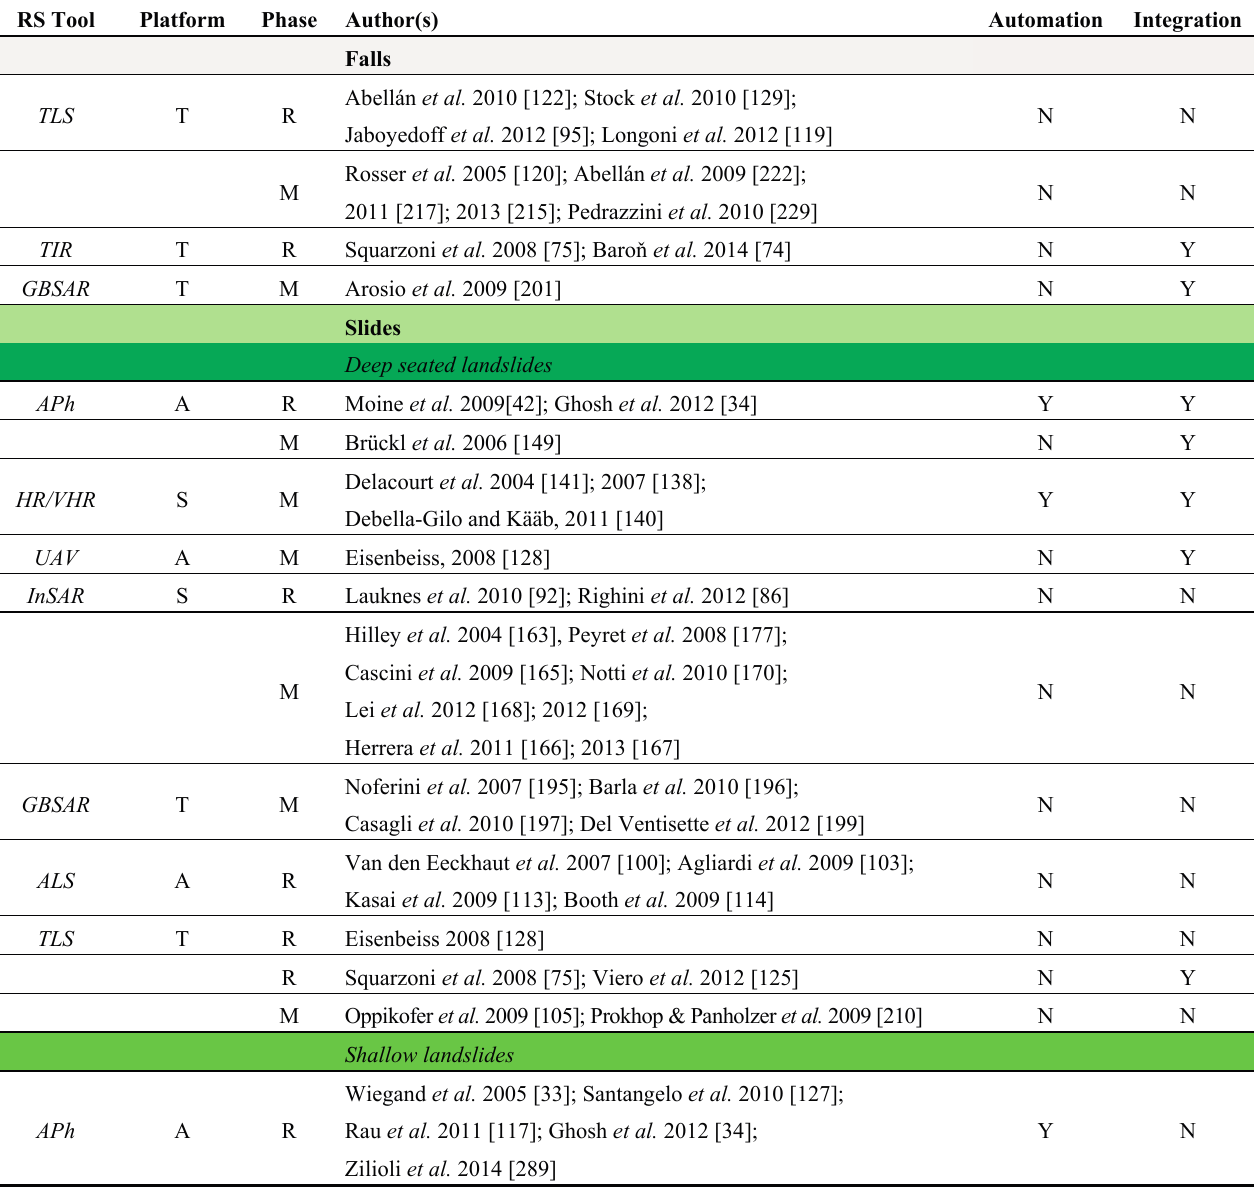
Table 4. RS techniques applied to different type of landslides for recognition and monitoring. Abbreviations (when not reported in the table at the end of the paper): APh = aerial photogrammetry; RF = remote rainfall measurements; T =